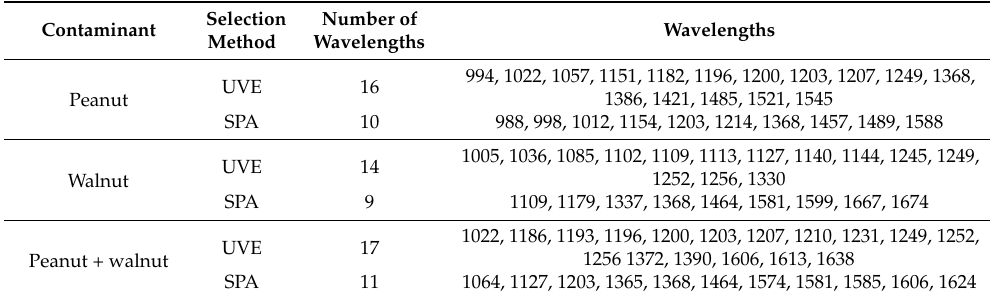
Table 3. Selected feature wavelengths for the peanut-contaminated flour, walnut-contaminated flour, and a combination of both, based on UVE and SPA selection methods,